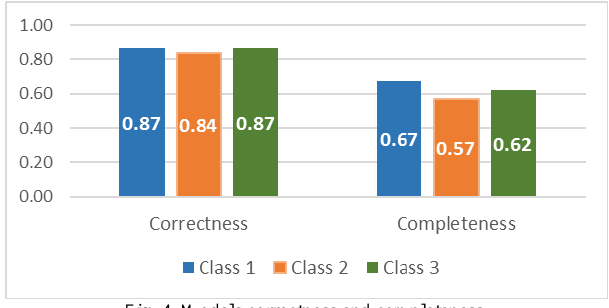
Fig. 4. Models correctness and